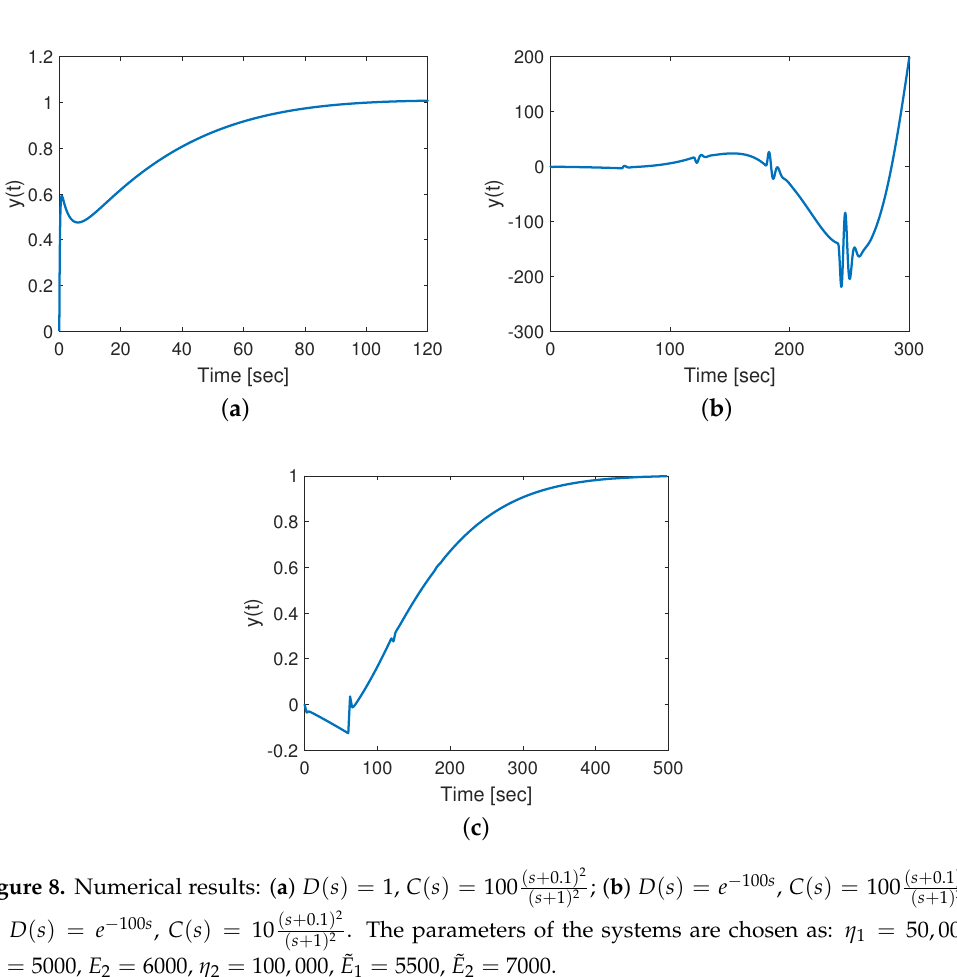
2 ; ( b ) D ( s ) = e − 100 s , C ( s ) = 100 ( s + 1 ) 2 ( s + 0.1 ) 2 . The parameters of the systems are chosen as: η 1 = 50,000, ( s + 1 ) 2